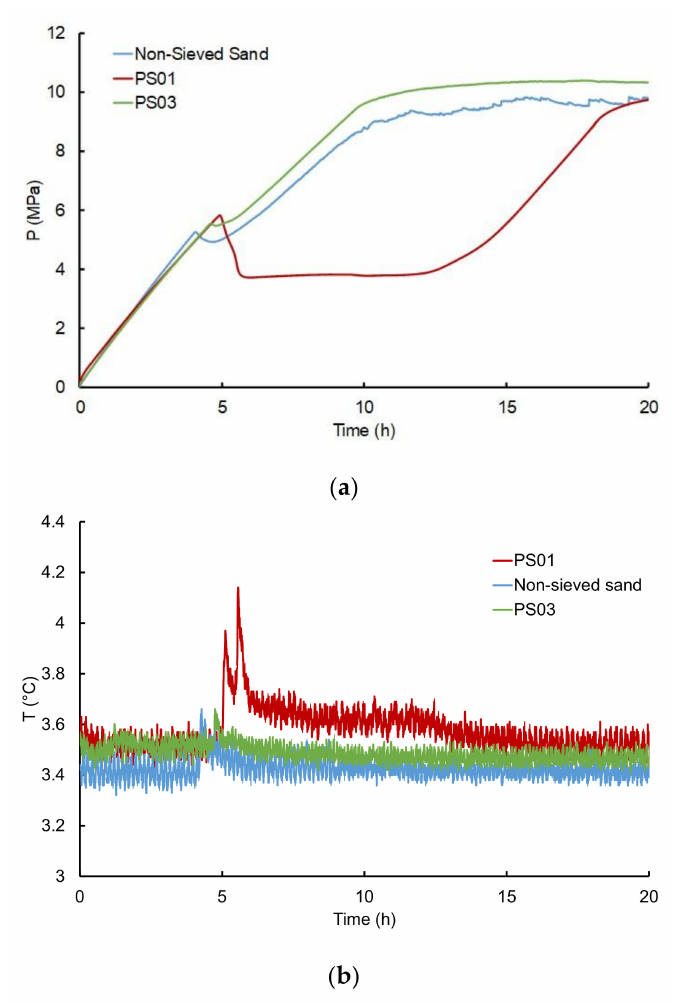
Figure 10. ( a ) Pressure and ( b ) temperature profiles during the methane hydrate formation step at around 53% water saturation and a gas flowrate of 29 mLn · min − 1 with di ff erent classes of particle